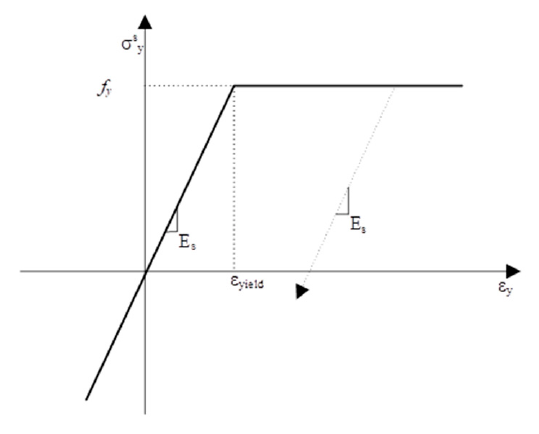
10 of 20 Figure 5. Element subjected to pure shear. 5. Developmental Study of the Finite-Element Model There were five phases in the development process of the finite-element model for the OSFT.